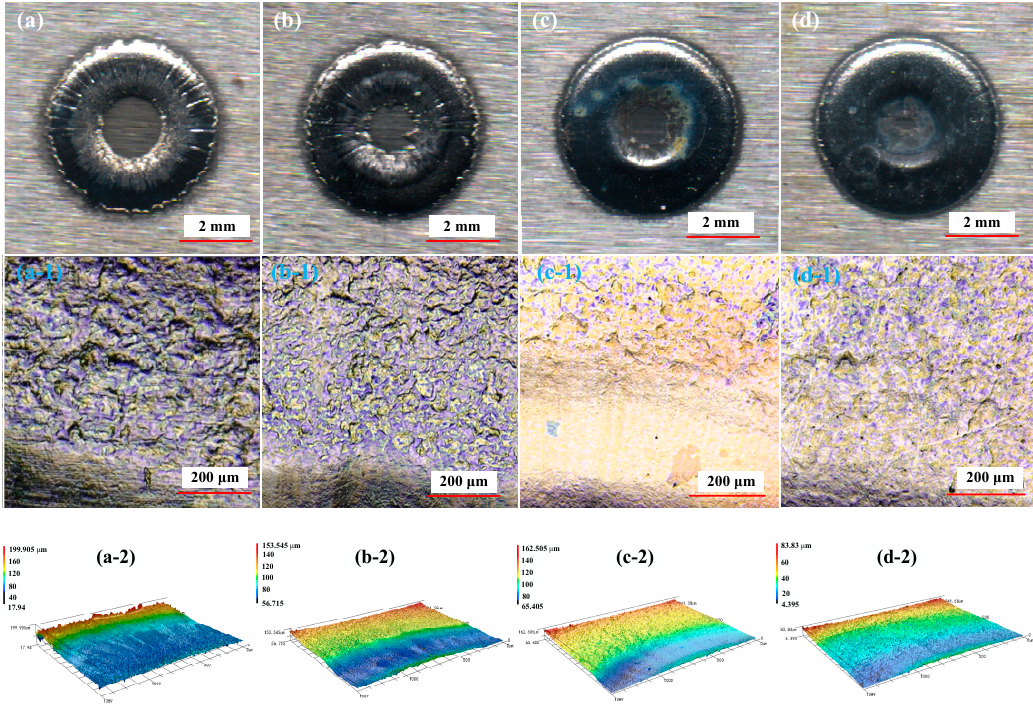
Figure 16. Surface morphology of workpiece at different concentration of NaNO 3 electrolyte: ( a ) 40 A/cm 2 , 100 g/L; ( b ) 40 A/cm 2 , 200 g/L; ( c ) 40 A/cm 2 , 300 g/L; ( d ) 40 A/cm 2 , 400 g/L. Micromorphology of workpiece local surface: ( a-1 ) 40 A/cm 2 , 100 g/L; ( b-1 ) 40 A/cm 2 , 200 g/L; ( c-1 ) 40 A/cm 2 , 300 g/L; ( d-1 ) 40 A/cm 2 , 400 g/L. 3D profile of workpiece local surface: ( a-2 ) 40 A/cm 2 , 100 g/L; ( b-2 ) 40 A/cm 2 , 200 g/L; ( c-2 ) 40 A/cm 2 , 300 g/L; ( d-2 ) 40 A/cm 2 , 400 g/L.